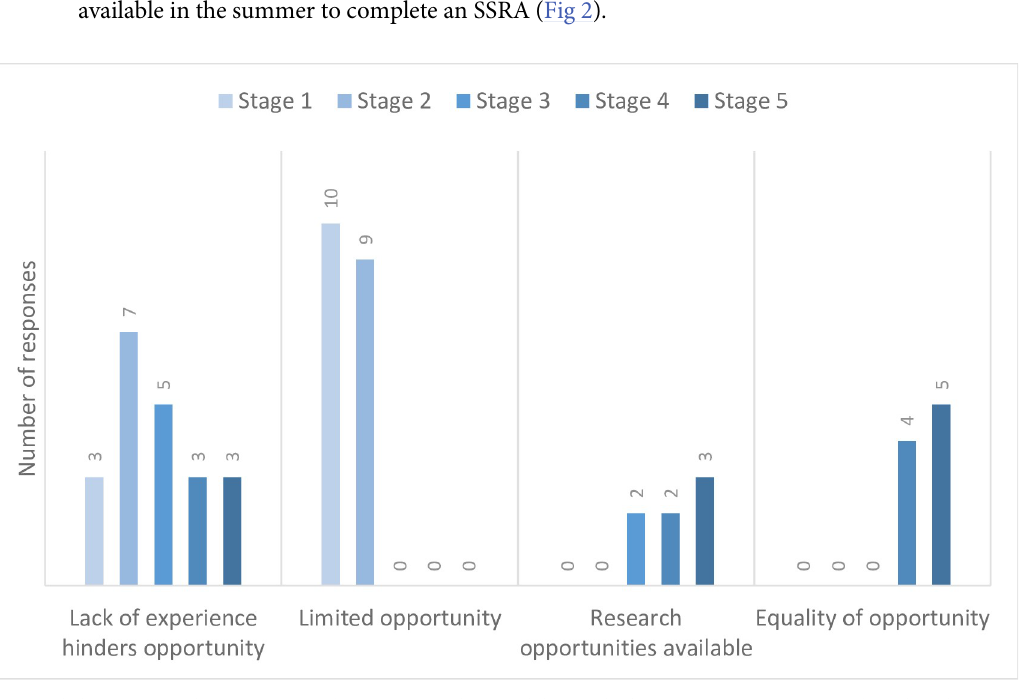
Fig 2. Coded responses referring to research opportunity discussed during the focus groups are represented as a bar chart showing the number of responses or references to opportunity across all 5 stages. In total, 56 responses or references to research opportunity were discussed during the focus groups. Lack of experiences being a barrier to research was discussed by students in all 5 stages. Early stage students described a lack of opportunity for research, whereas later stage students were more aware of a variety of research opportunities, however considered there was an inequality of opportunity to undertake